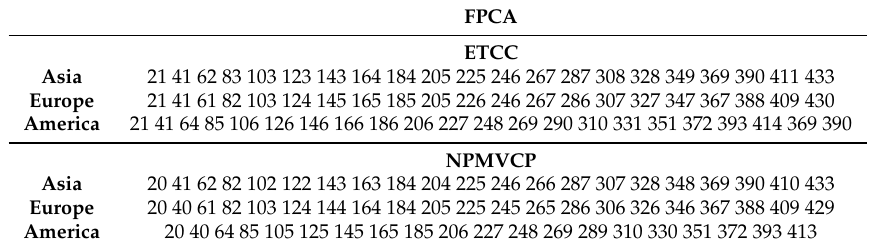
Figure 8. FPCA plots of America (1/3/2013 to 10/6/2014). Table 16. Change point detection by ETCC and NPMVCP of FPCA with real exchange currency data (1/3/2013 to 10/6/2014).